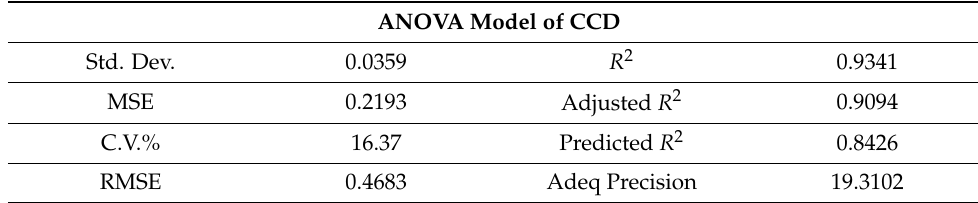
Table 3. The statistical analysis of the CCD-based ANOVA model.